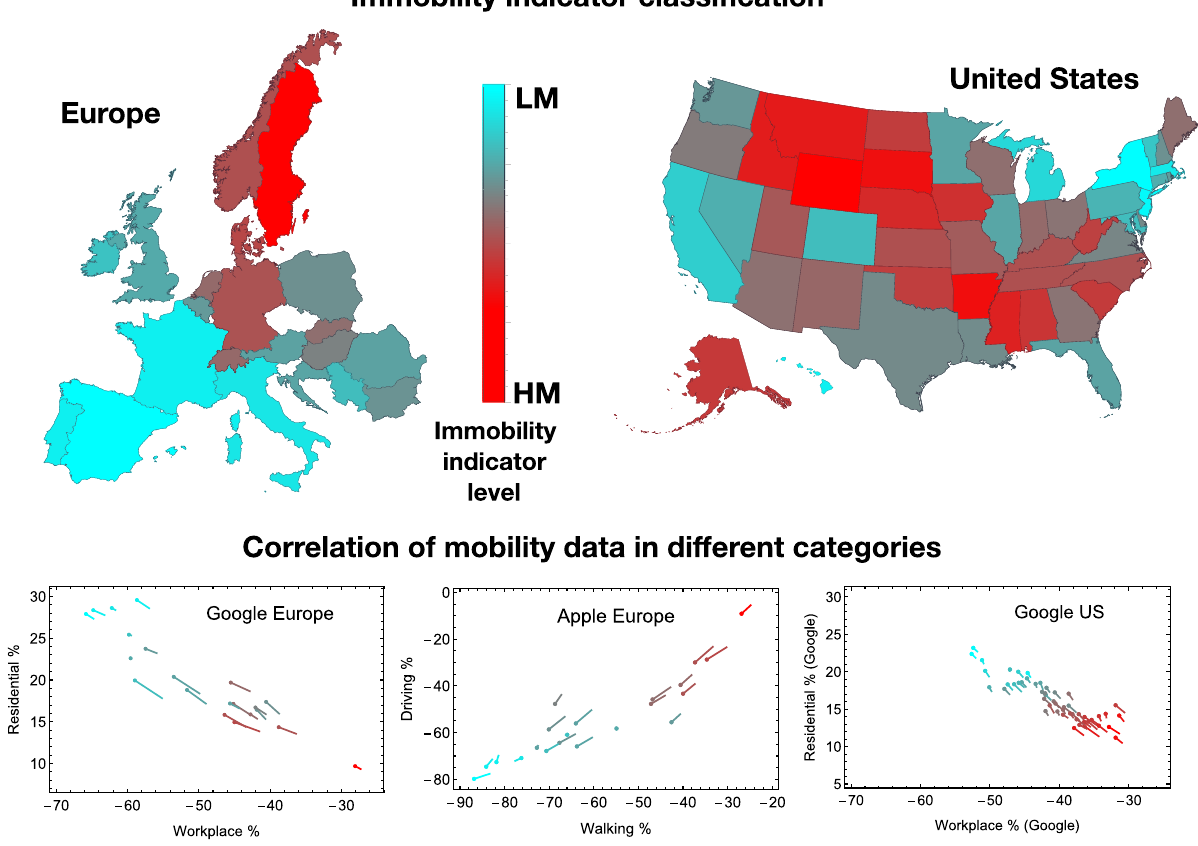
Figure 1. The COVID-19 Mobility Map for Europe and the US. The two maps represent respectively the European and US states with different shades of mobility from the highest (HM) in bright red to the lowest (LM) in cyan. At the bottom of the figure there are three tadpole-like plots showing correlations between the four mobility reduction categories: Residential and Workplace from Google, Driving and Walking from Apple. The head of the tadpoles correspond to the average over 6 weeks after social distancing begins, while the tail indicates a 8 week average. The colour code in the three plots reflects the maps one. The maps are drawn with Wolfram